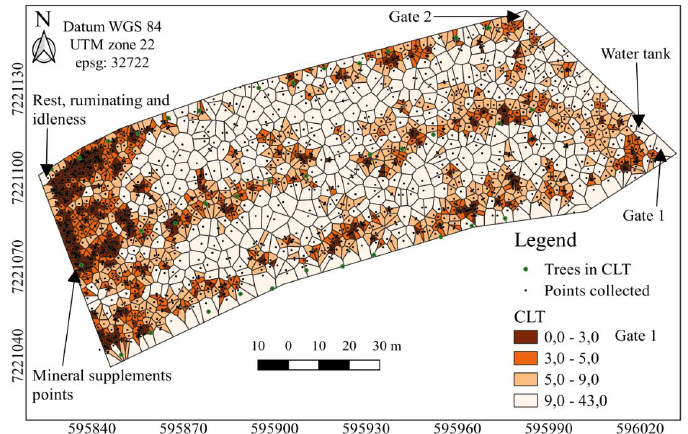
Figure 4. Thiessen areas of the spatial distribution of the dung, in the different systems: CLT, crop–livestock–tree systems, considering all samples. Dark brown represents areas with high concentration of cattle dung, whereas the white indicates areas without cattle dung. Axes X and Y with UTM coordinates (m). The geostatistical parameters of the Thiessen areas in the evaluations performed are shown, depending on the different ICLS (Table 4). It is observed that the data adjusted to the different models with a strong Spatial Dependence Degree (SPD). The range varied from 12 to 84 m, for the CLT (Table 4). It must be considered that Sampling 1 was performed one day after the animals entered. Considering all the samples, the range was 31 and 25 m for the CL and CLT, respectively. The semivariogram shows the spatial distribution of the cattle dung, considering all samples, in the different ICLS (See Figure A1). A decrease is visible in the semivariogram over the short and long distances and an increase in the semivariogram is observed at medium distances. Table 4. Geostatistical models of the Thiessen areas in each sampling period, in the different integrated crop–livestock systems (CL, crop–livestock and CLT, crop–livestock–tree systems). Systems Sampling Model